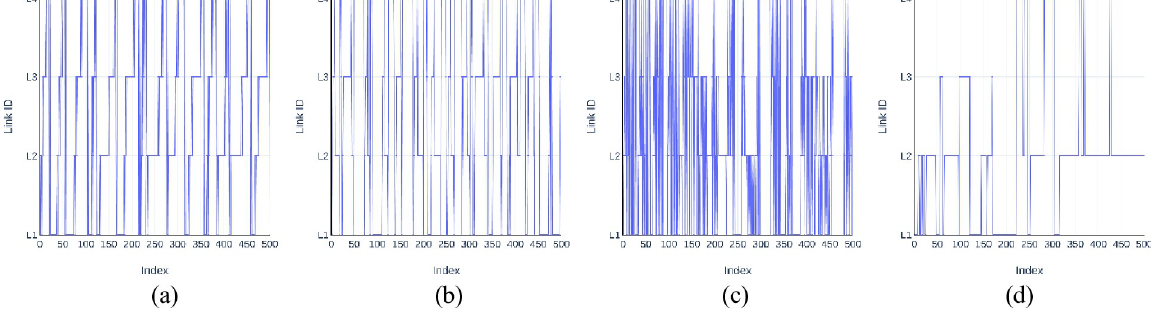
Fig 4. Link switching time series of Cloak 9,8,5 (32,4) and TCP_trans(4). (a) Cloak 9 (32,4) . (b) Cloak 8 (32,4) . (c) Cloak 5 (32,4) . (d) TCP_trans(4).